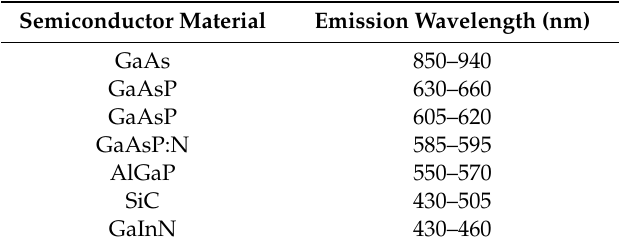
Table 1. Electroluminescent peak emission of selected